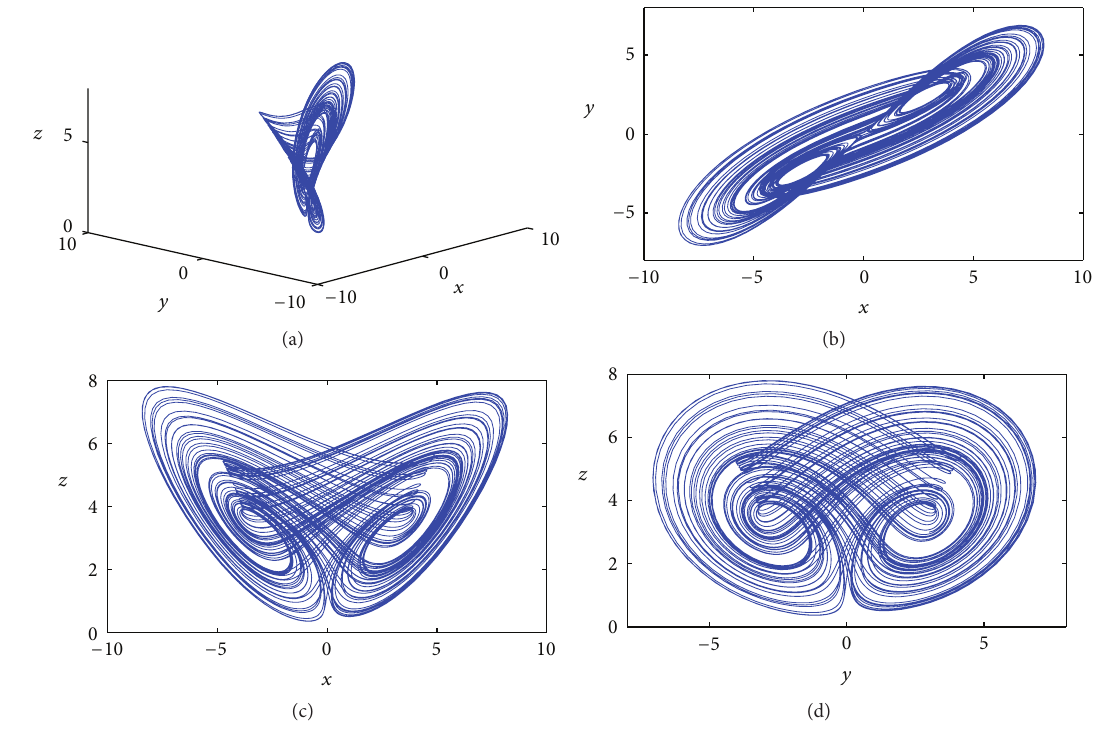
Figure 1: 3D view of the attractor and its various projections.